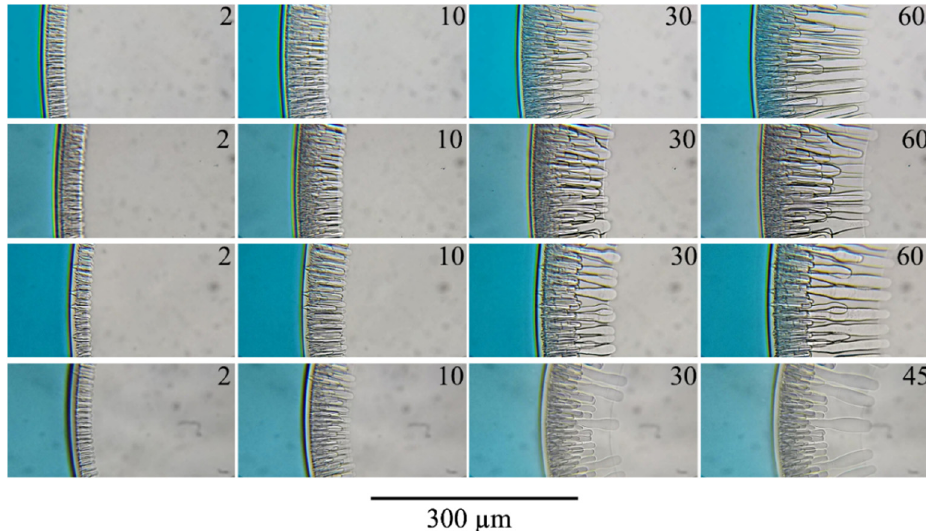
Figure 9. The evolution of the structure of a mixture of 15 wt.% PAN with NMP (composition 5)—upper row; 15 wt.% PAN with NMP/Acetone ratio 90/10 (Composition 6)—second row; 15 wt.% PAN with NMP/Acetone ratio 70/30 (Composition 7)—third row; 20% PAN with NMP (Composition 8)—the bottom row. The time in seconds from the moment of contact between the sample and the non-solvent is indicated in the upper right corner of each photo.